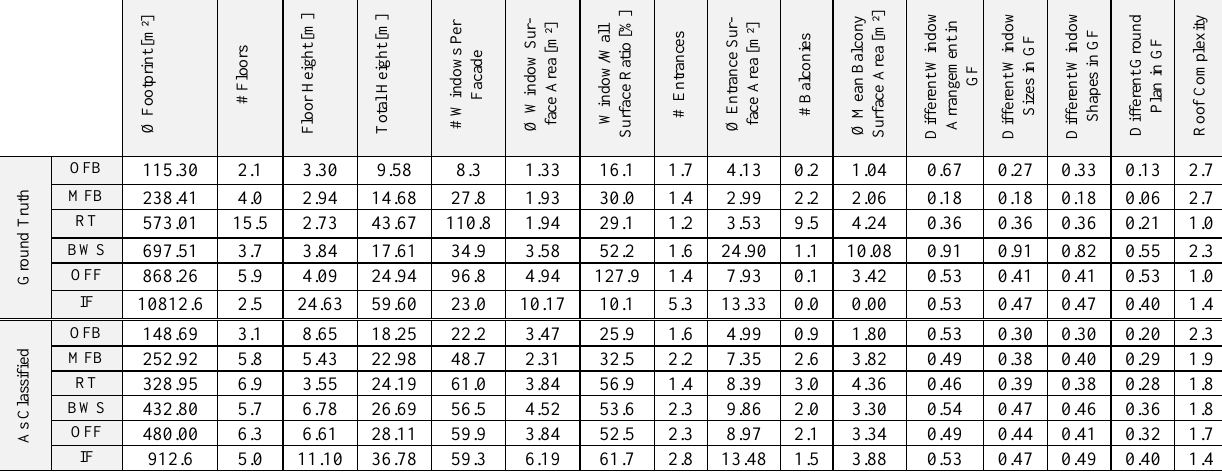
Table 2. Geometric properties of the building categories as given in the ground truth (upper part of the table), and as classified by the users in the study (lower part of the